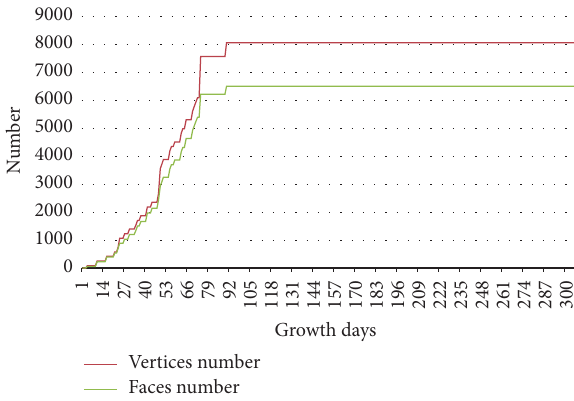
Figure17:Theverticesandfacesnumbersstatisticsinagrowthcycle of a tomato plant in our TomatoVis system. As in most cases, the growth cycle for tomatoes is 4–6 months, and from the 91st day, the vertices and faces numbers are not increased